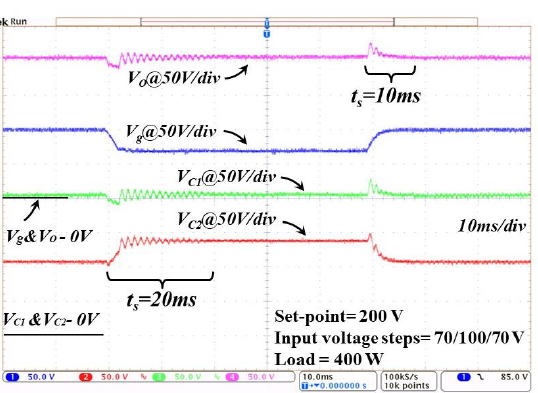
Figure 27. Closed-loop test, the input voltage Vg changes from 100 V to 70 V and then 100 V again, Vo is regulated to 200 V , Po = 400 W .